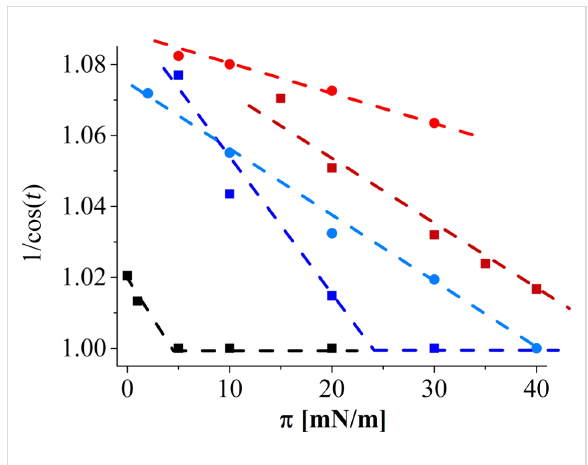
Figure 7: 1/cos( t ) as a function of the surface pressure of C1P mono- layers at 20 °C on (red circle) pH 9 with calcium; (red square) pH 9 without calcium; (blue circle) pH 4 with calcium; (blue square) pH 4 without calcium; and (black square) on